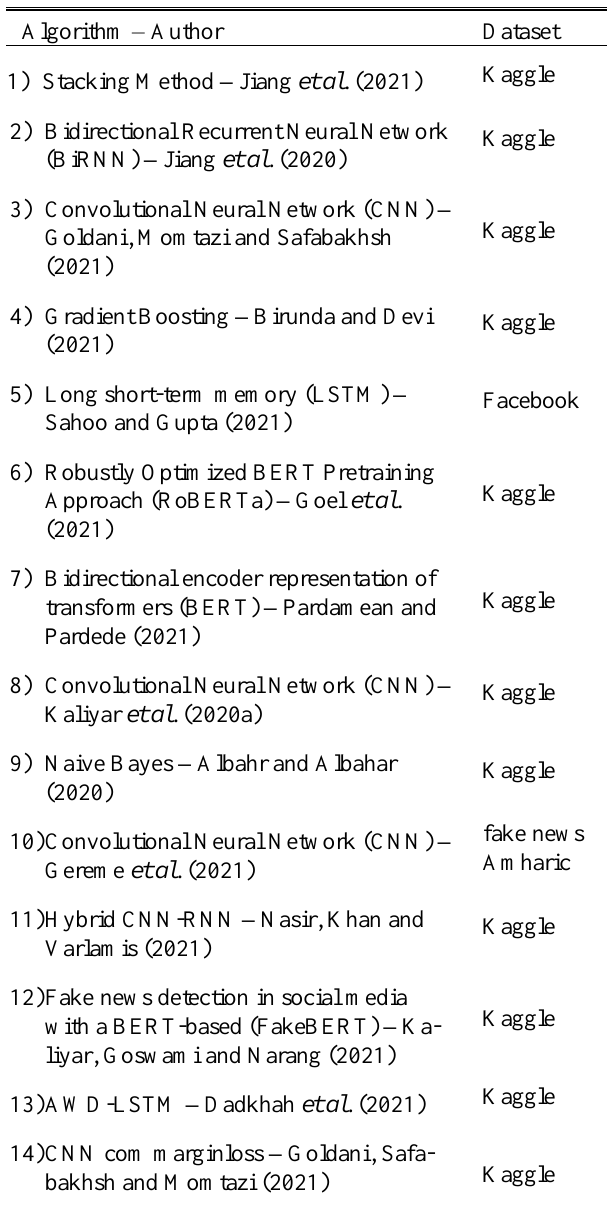
Table 5. Algorithm and dataset used for each of the analyzed studies. Source: The